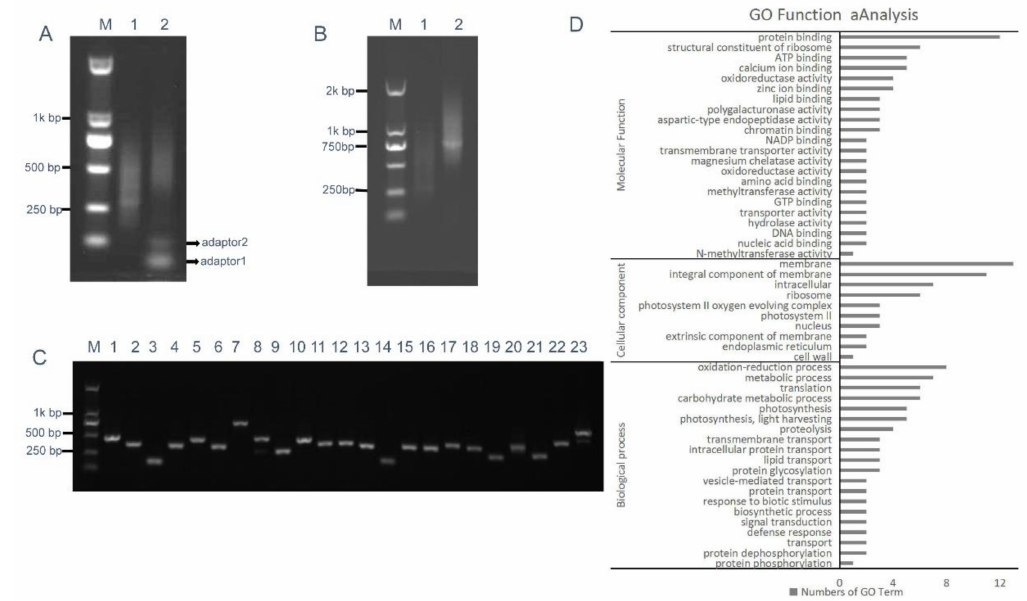
Figure 5. RCA-mediated ihpRNA mutant library construction of B. napus. ( A ) The intermediate cDNA library was digested with Bsa I, generating DNA fragments of 200–700 bp in size with two di ff erent Bsa I adhesive termini (lane 1), and purified Bsa I-digested cDNA library insertional fragments were ligated with adaptors 1 and 2, leading to closed circular DNA molecules (lane 2). ( B ) The RCA products were digested with Bam HI and Sac I to release single-unit inverted repeats. DNA fragments of 400–1400 bp, representing the single unit inverted repeats (lane 2), were approximately double that of the unamplified Bsa I-digested cDNA control (lane 2) in size. ( C ) Random PCR of inserts in the binary pBI121. Approximately 100% of the clones contained inserts ranging from 200 to 800 bp in size (lanes 1–23). ( D ) Histogram showing Gene Ontology functional analysis of randomly selected insertional fragments. The frequency of GO terms was analyzed using GO Slim Assignment. The y-axis and x-axis indicate the names of clusters and the number of genes in each cluster,